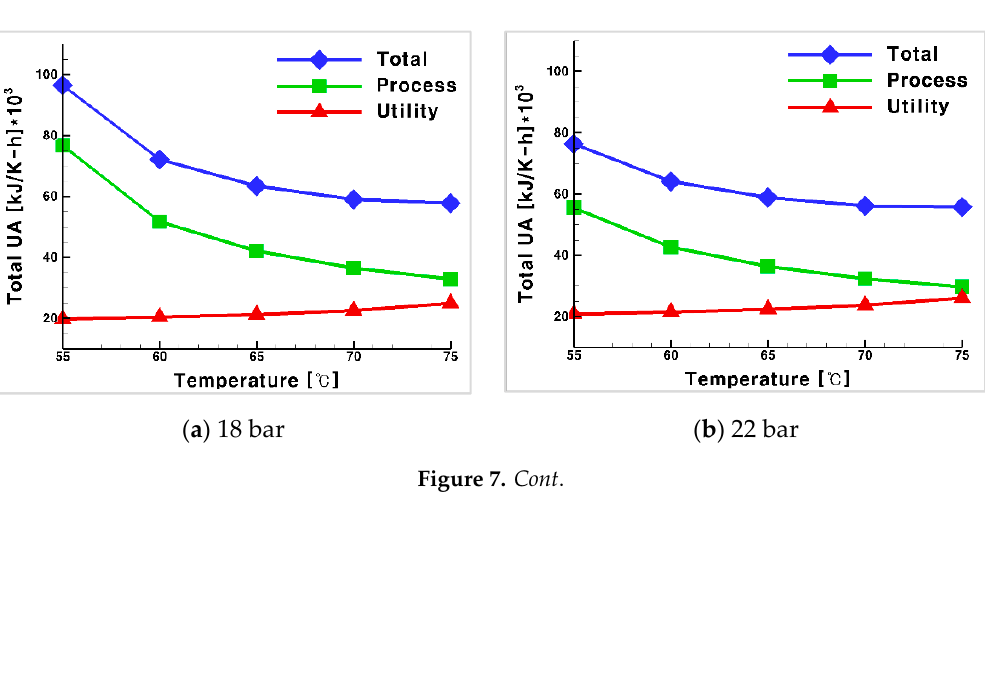
Figure 6. Heat transfer performance based on the temperature in each group when using glycol